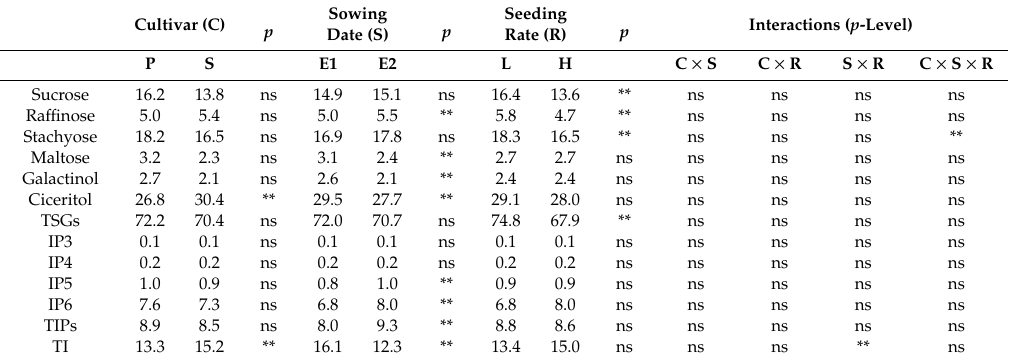
Table 2. Trial 2: E ff ects of cultivar (Pasci à versus Sultano), sowing date (E1 versus E2) and sowing rate (low versus high) on the content of galactosides and inositol phosphates (g kg − 1 DM) and trypsin inhibitors (TIU mg protein − 1 ) in chickpea